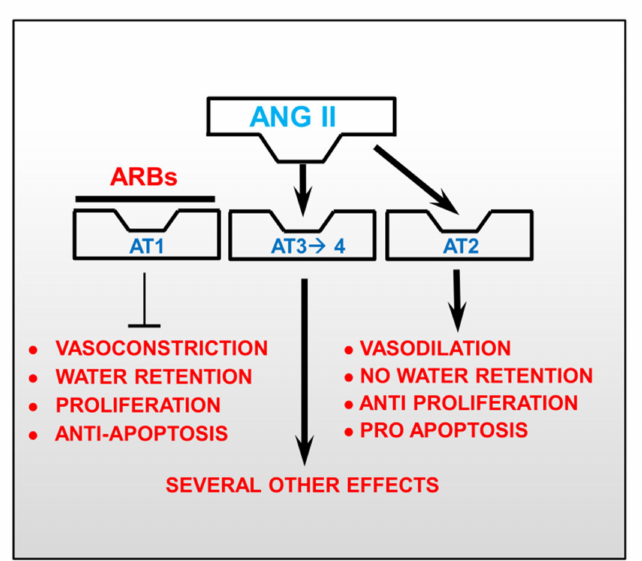
Figure 2. Effects of angiotensin II receptor blockers (ARBs). ARBs bind to angiotensin II (Ang II) receptor type 1 (AT1) contrasting vasoconstriction, water retention, promoting proliferation, and limiting apoptosis in the endothelium. When AT1 is inhibited, the circulating Ang II can only bind to the Ang II receptor type 2 (AT2) causing vasodilation, no water retention, reduced proliferation, and increased apoptosis of endothelial cells. In addition, Ang II may also bind to Ang II receptor type 3 and 4 (AT3 and AT4), exerting additional effects that are not fully known